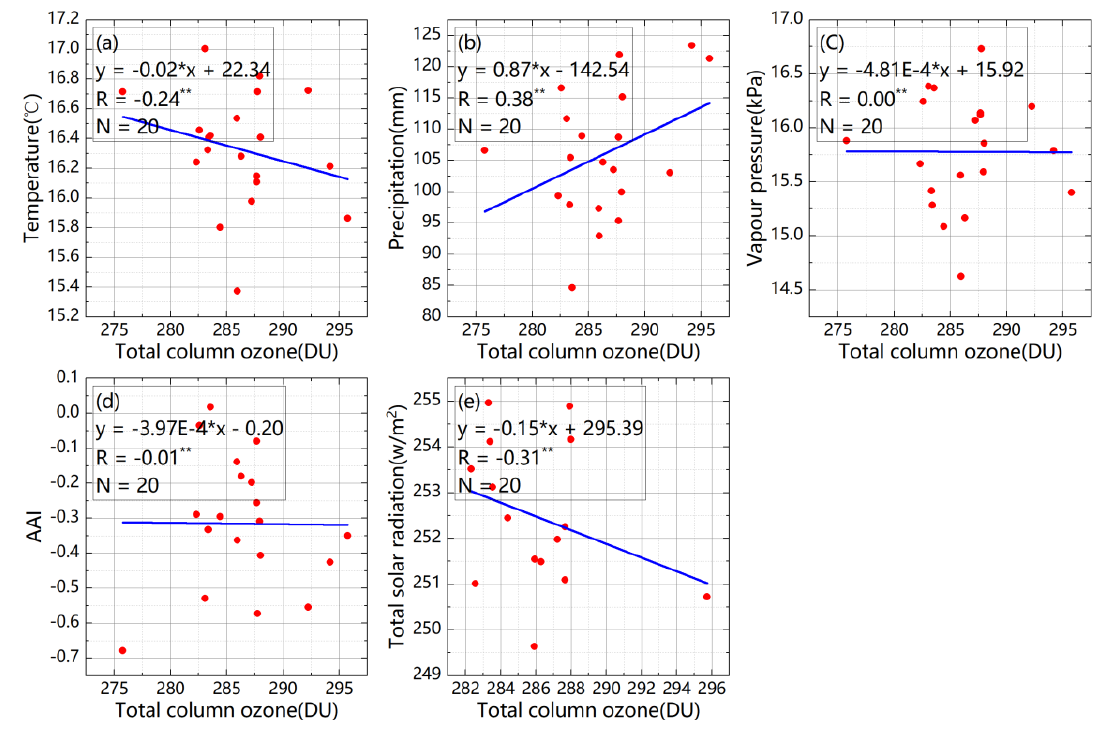
Figure A4. Scatter plot of inter-annual time variation of the TCO and meteorological factors. Table A1. Scatter plot of monthly statistical parameters of the TCO and meteorological factors. Variable